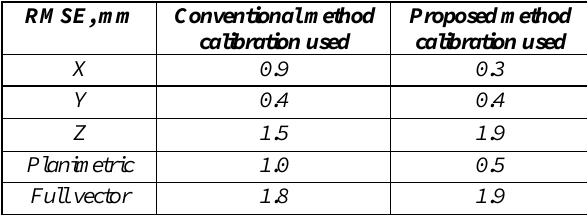
Table 3. RMSE of discrepancies at the check